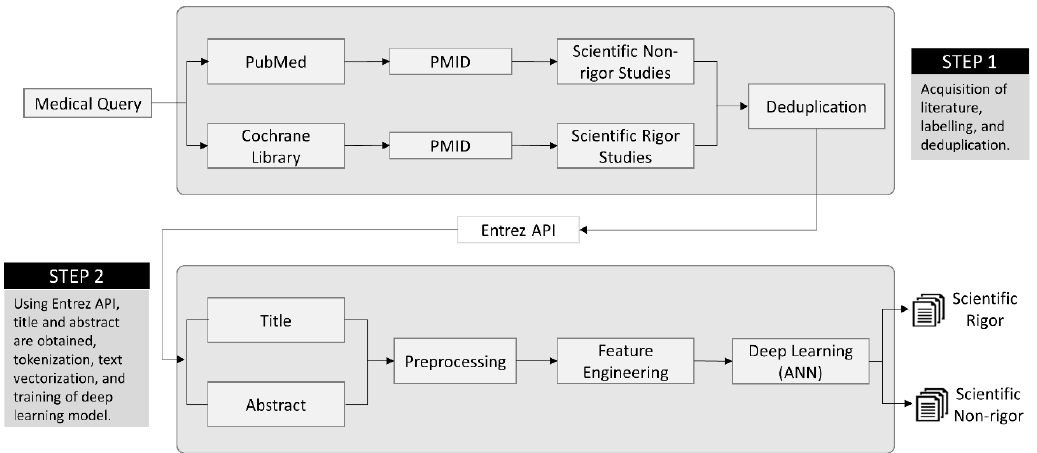
Figure 1. The high-level architecture of the proposed method for finding high-impact studies in biomedical literature.